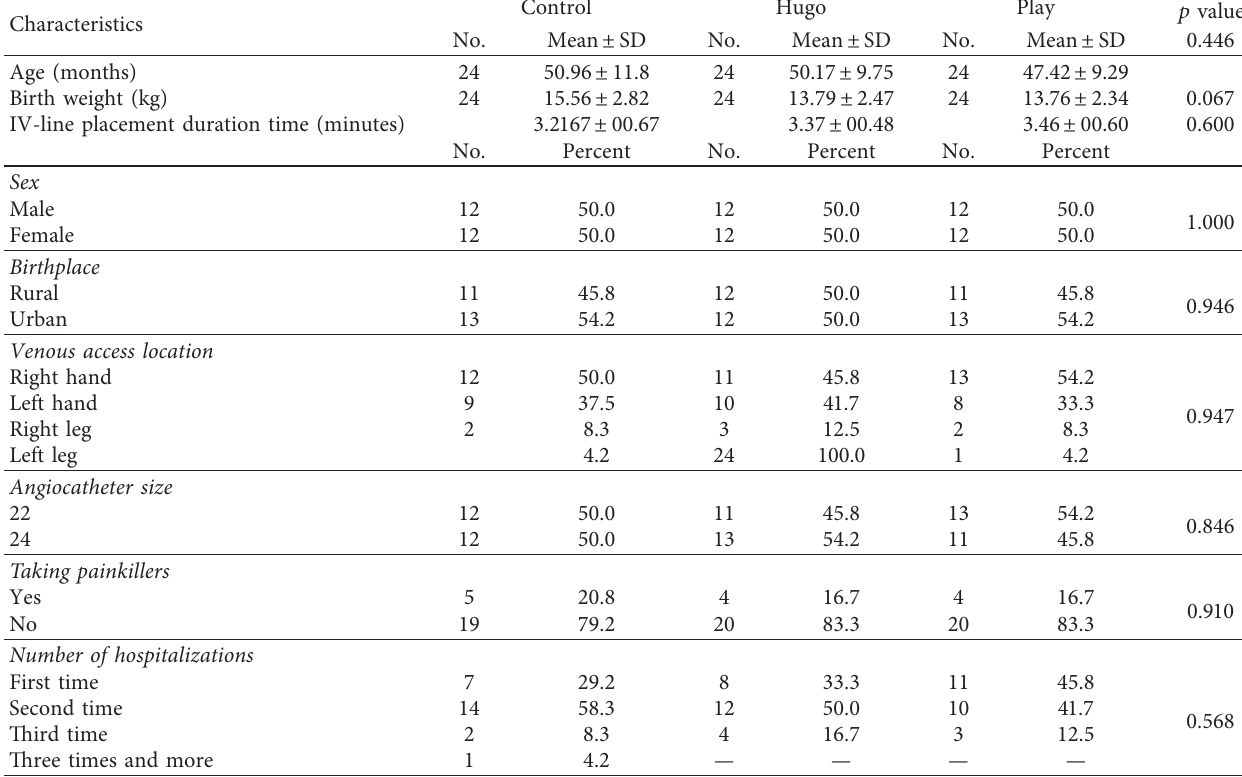
Table 1: Demographic characteristics of the three